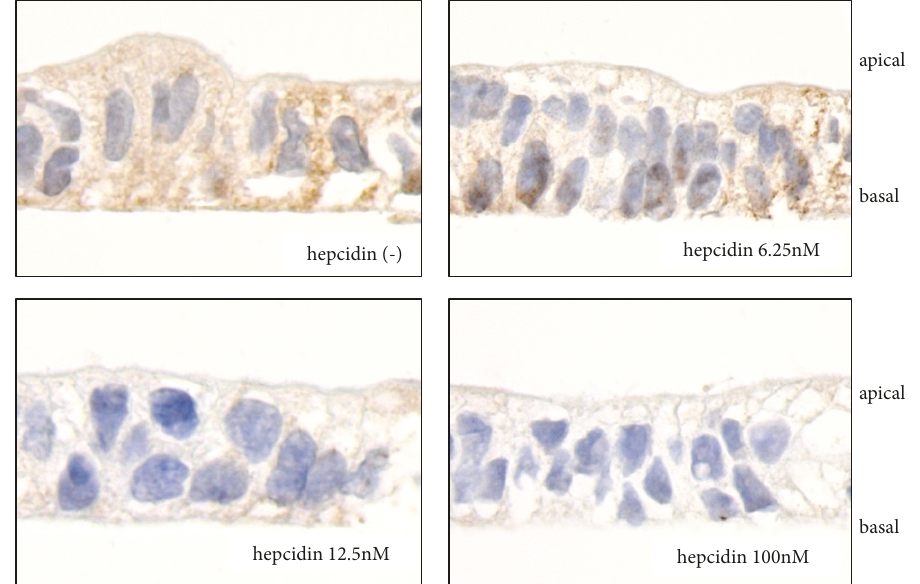
Figure 6: Immunohistochemical detection of FPN in Caco-2/TC7 cell monolayers was cultured with or without hepcidin (0-100nM). FPN expression in Caco-2/TC7 cell monolayers was downregulated dependently on hepcidin concentration.